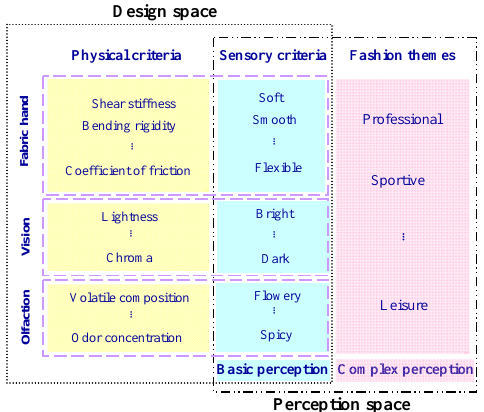
Fig. 1: Fig. 1. Relation between design space and perception